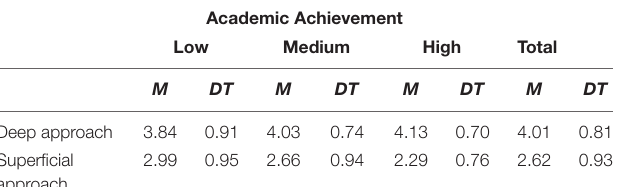
TABLE 2 | Descriptive statistics (mean, standard deviation) corresponding to each of the levels of prior academic achievement in the variables related to motivational and cognitive engagement (approach to